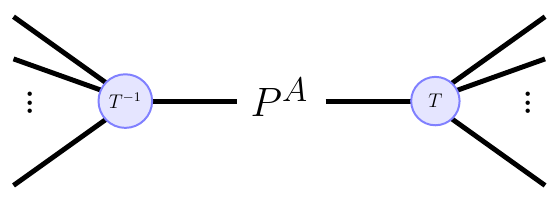
Figure 2. Left hand side of equation